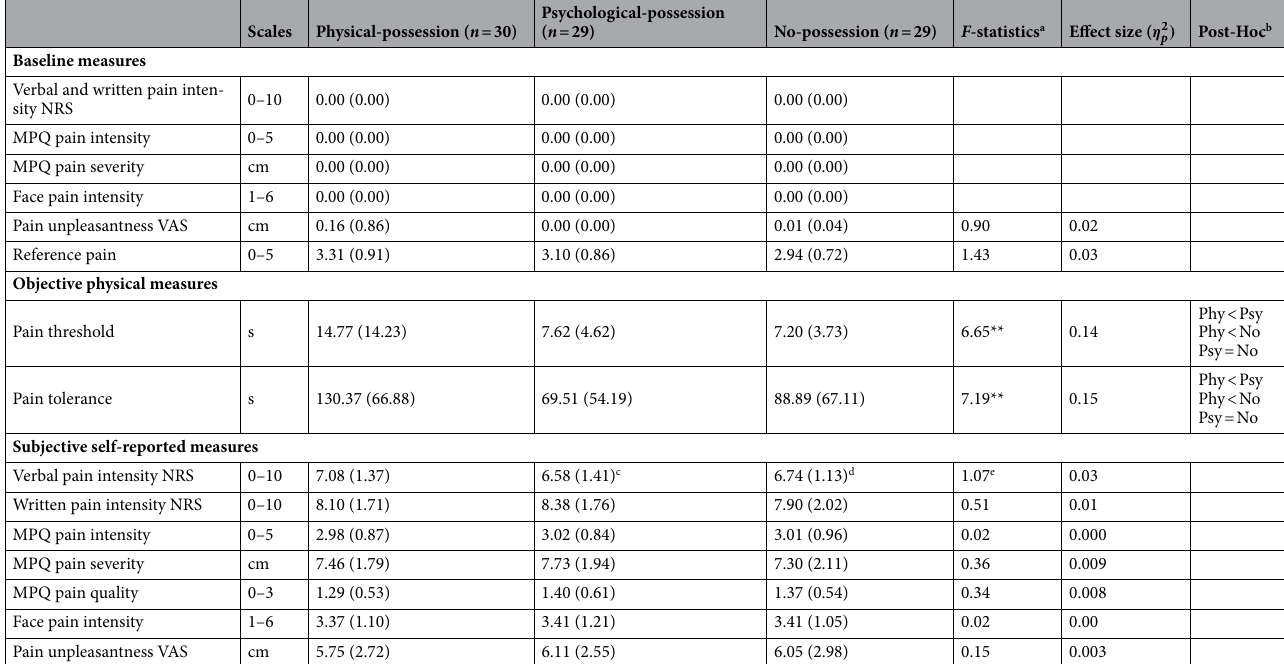
Table 3. The means, standard deviations, (in parentheses) and F-statistics of pain outcomes as a function of possession condition. Values outside parentheses are means, inside are standard deviations. Phy physical possession, Psy psychological possession, No no possession. ** p < 0.005. a For univariate F -tests, degrees of freedom are (2, 85). b Games–Howell post-hoc comparisons were utilized. c n = 27. d n = 26. e For univariate F -tests, degrees of freedom are (2,